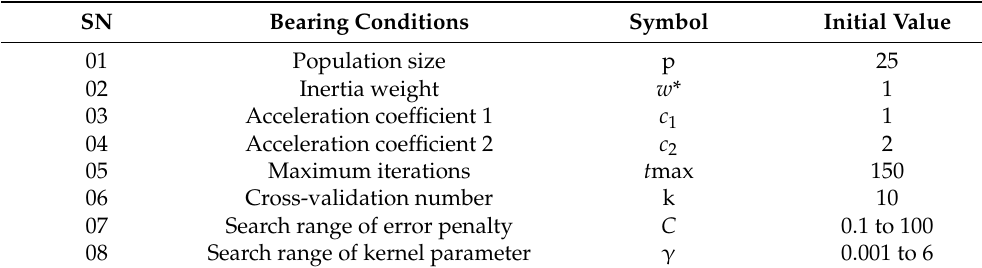
Table 2. Initialization parameters of PSO–SVM